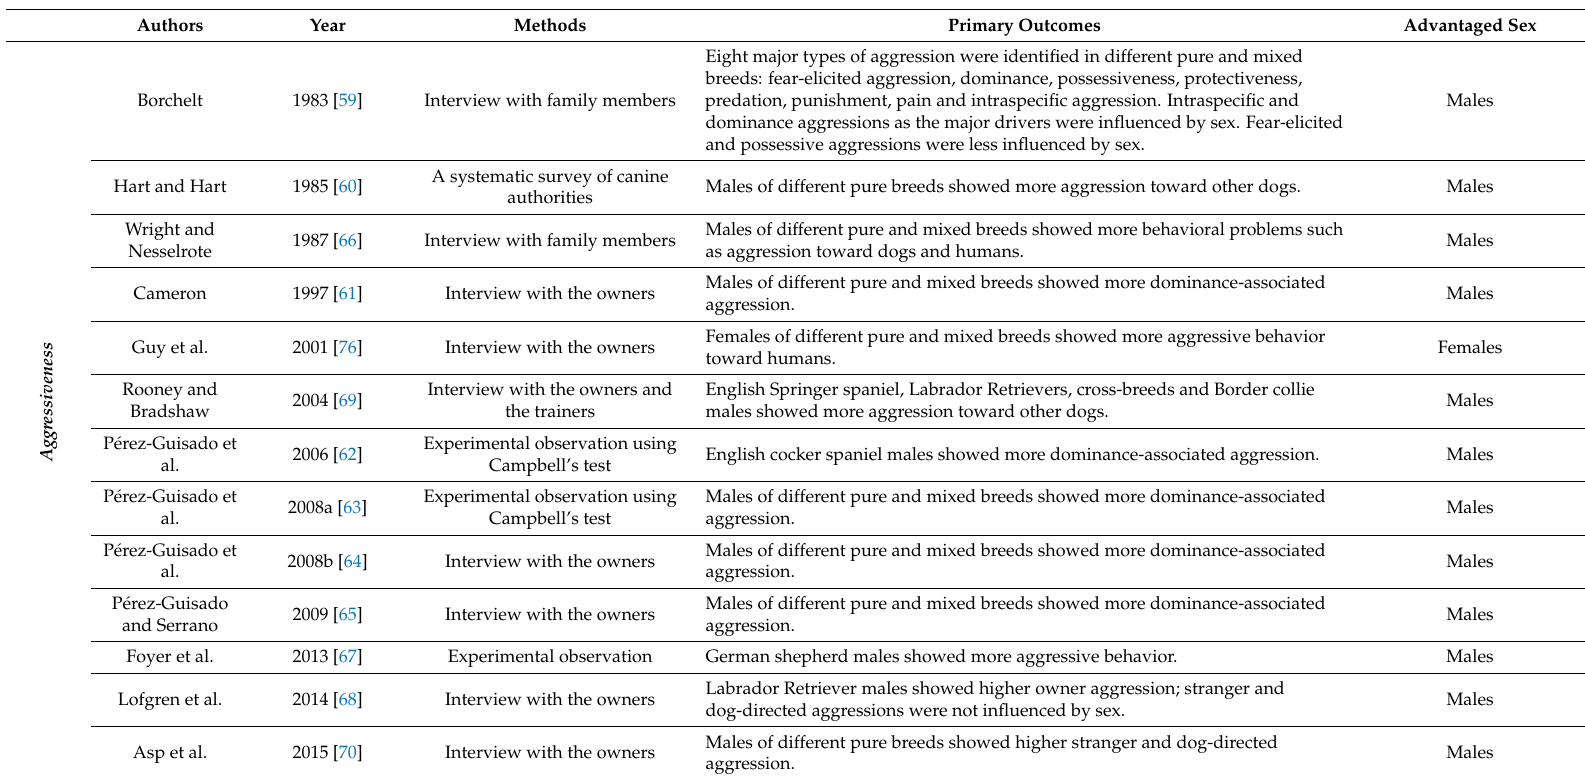
Table 1. List of scientific publications analyzing sex differences in